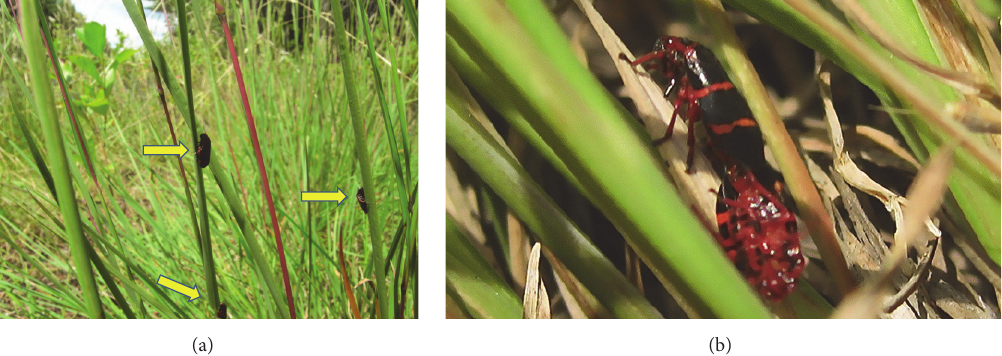
Figure 5: Prosapia ignipectus , lined form: (a) sitting characteristically exposed while feeding on stems of Little Bluestem and (b) mating among stems of Little Bluestem, female above and male